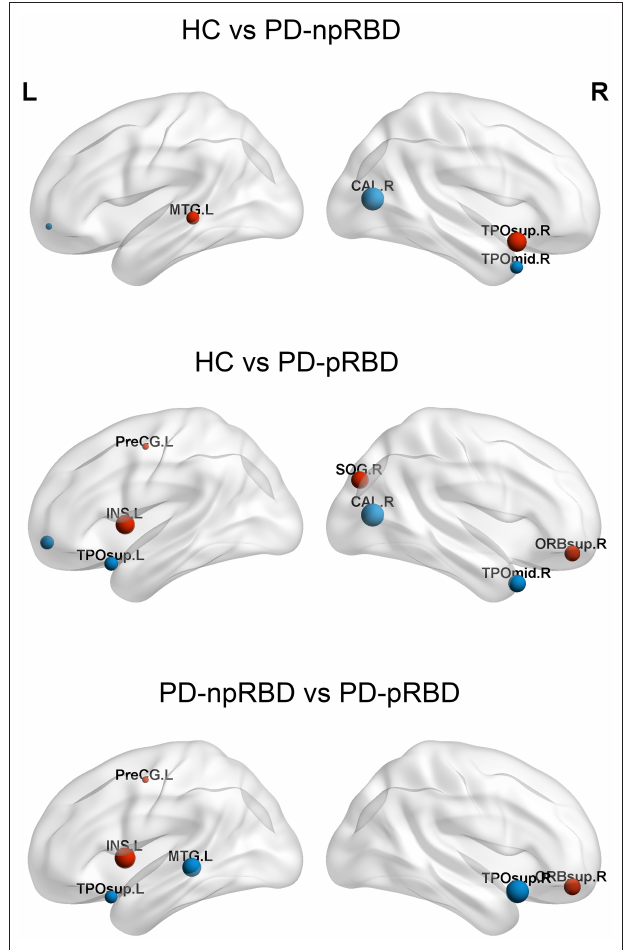
FIGURE 3 | Differences of hubs in the HC, PD-npRBD, PD-pRBD. The size of the node reflects the value of the nodal degree. The blue dot represents the hub in the former group but not in the latter, and the red node is the opposite. The abbreviations of the 90 brain regions are given in Supplementary Materials (Online Resource). L, left hemisphere; R, right